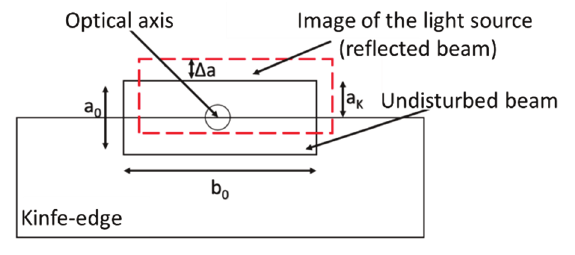
Fig. 8. Knife-edge principle of operation [22] As a result, the rays that have been refracted from the axis, increase the camera's matrix illumination (if Δ a is positive) or are blocked on the blade (if Δ a is negative) causing local drop in the luminosity of the observed sam- ple. The relationship regarding the contrast at a given point is defined as